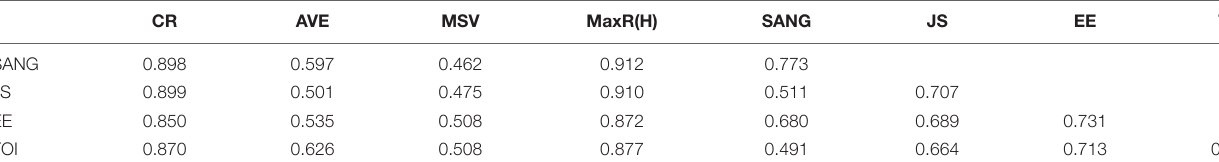
TABLE 4 | Discriminatory validity.